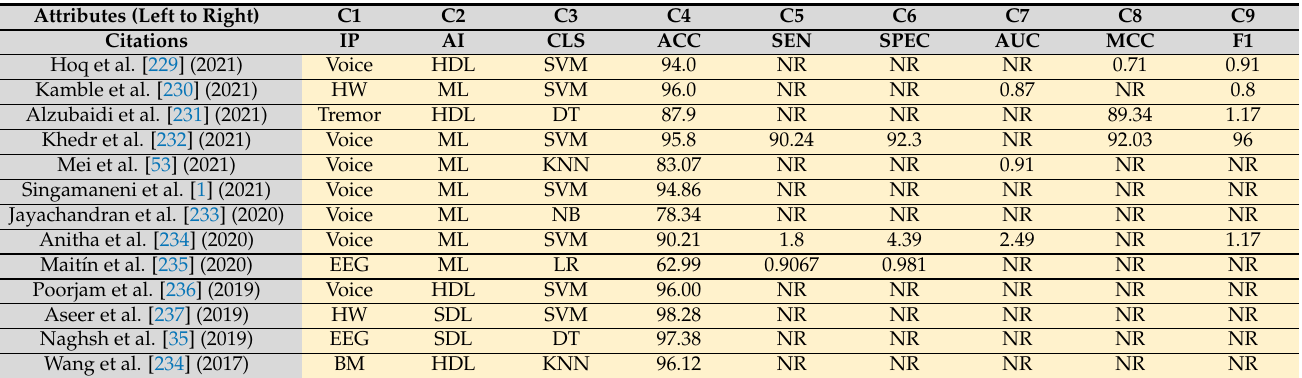
Table 5. AI techniques and their performance for PD detection without